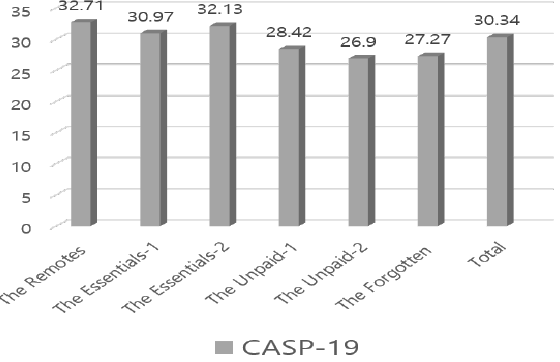
Figure 1. MCM-K(Multidimensional Calling Measure), Participants ’ occupational calling by our Korean-adapted version of the new classes of occupation owing the COVID-19 pandemic.